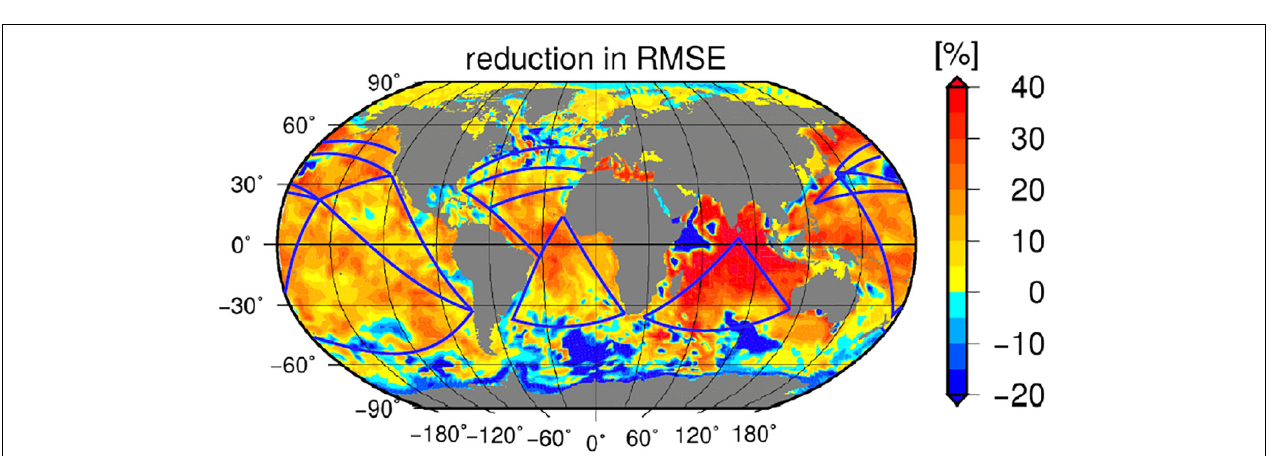
FIGURE 4 | Sea level trend in mm/year as derived from TOPEX, Jason-1, and Jason-2 for 1992–2018. Blue lines denote possible future SMART cable routes. Altimetry data is courtesy of NOAA/NESDIS Center for Satellite Applications and Research, and provided by the NOAA Laboratories for Satellite Altimetry (NOAA/NESDIS, 2018). Permission obtained for use of